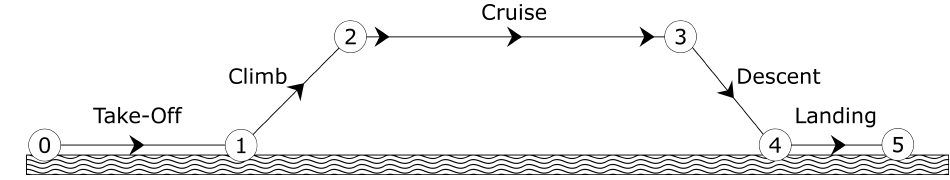
Figure 2. Mission Profile.